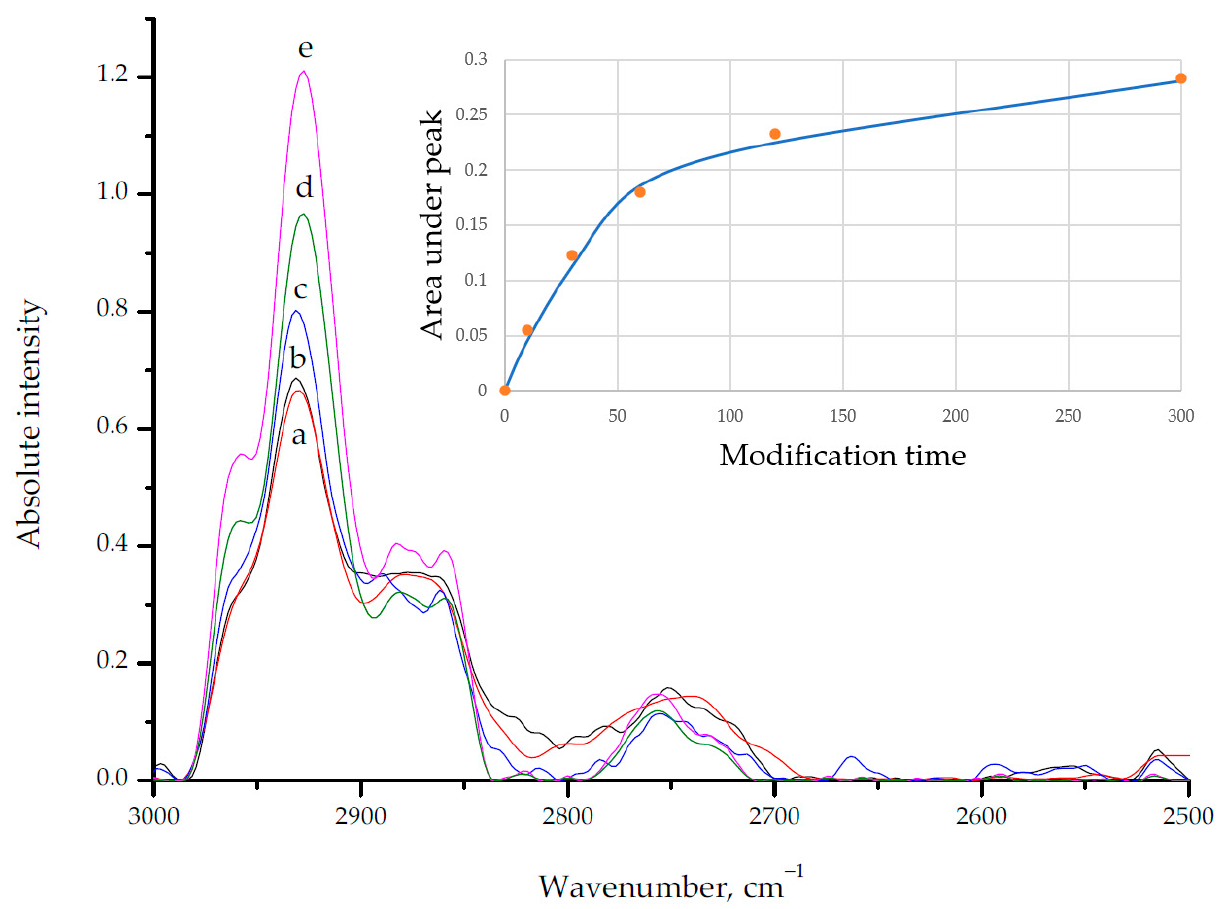
Figure 5. FT-IR spectra of modified glass microspheres with different modification times: a—10 s, b—30 s, c—60 s, d—120 s, e—300 s. Insertion–calculated peak area fitted by Langmuir-type model Equation (1).